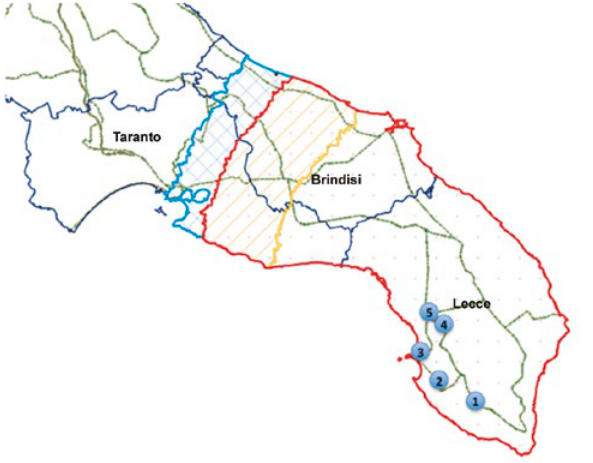
Figure 1. Geographical origin of 14 strains of Xylella fastidio- sa isolated from different hosts (four Olea europaea cultivars and Nerium oleander ) naturally infected and displaying symptoms of OQDS in the outbreak area of Salento (data reported in Table 1). Site 1, Ugento; site 2, Taviano; site 3, Gallipoli; site 4, Seclì-Galatone; site 5, Galatone. The map is adapted from “http://webapps.sit.puglia.it/freewebapps/ DatiFasceXF/index.html” June 2017. The dark blue line designates Provinces of Lecce, Taranto and Brindisi; the red line the containment area, the yellow line, the last 20 km where infected plants have to be removed if present). The light blue line indicates buffer zones (infected plants, if found, and all host plants within a 100 m radius to be re- moved). Green lines indicate main roads and